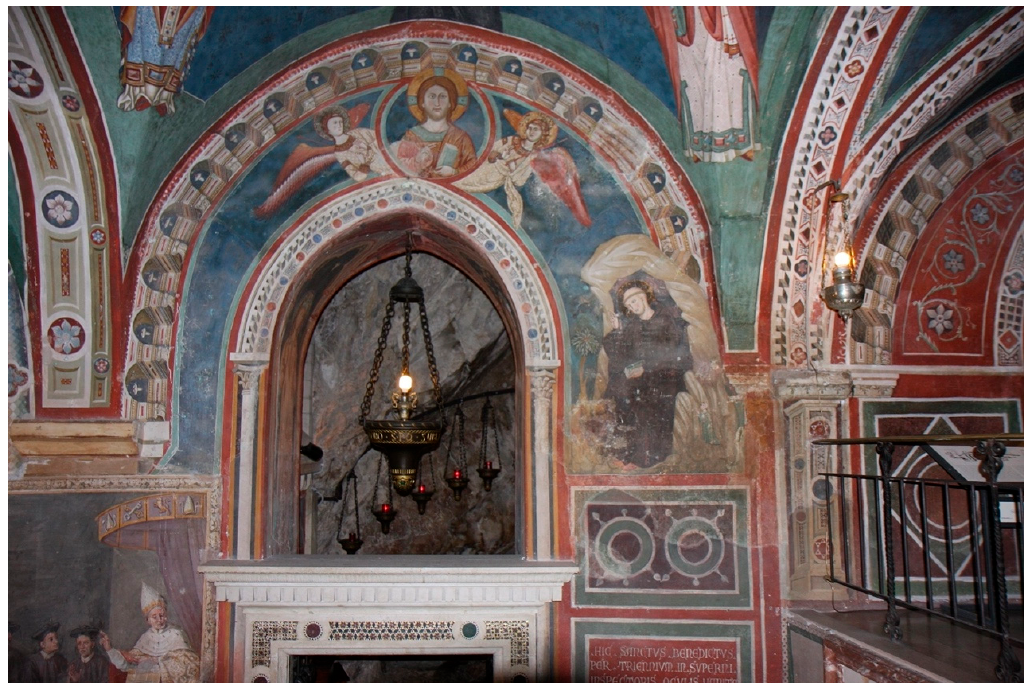
Figure 17. Sacro Speco, Subiaco (Italy), Lower Church. Fresco. St. Benedict pointing out the cave. Photo: Davide Giannetti.